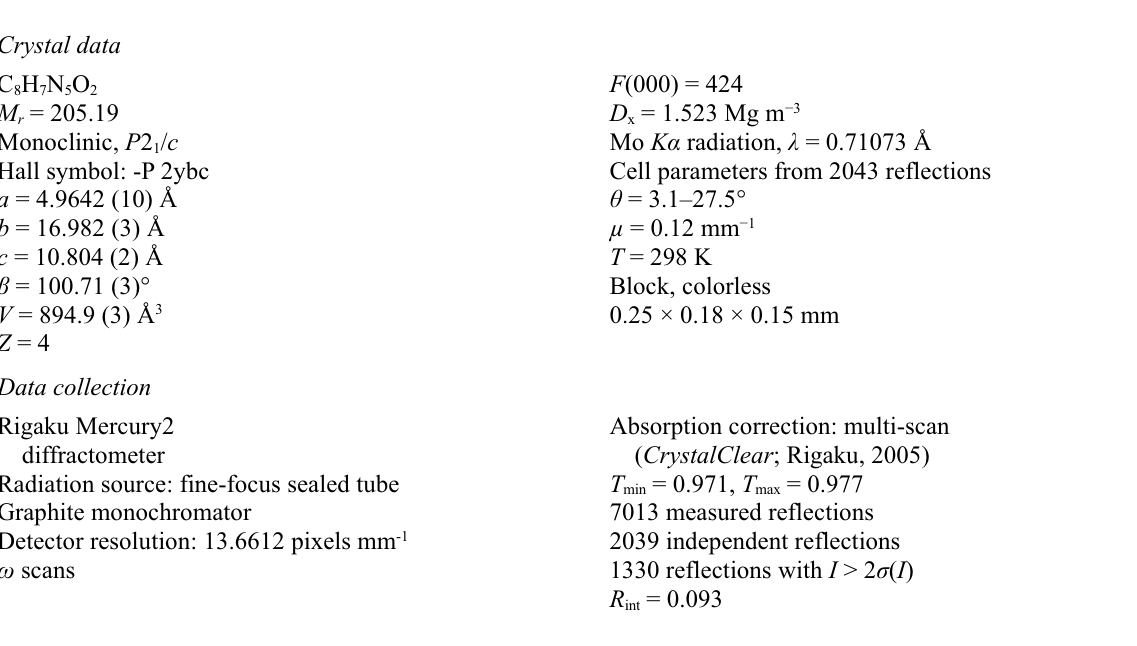
Figure 2 Partial packing of the title compound showing the one dimensionnal hydrogen bondings network. Hydrogen atoms not involved in hydrogen bonding (dashed lines) have been omitted for clarity. [Symmetry code : (i) x-1, y, z] 5-(4-Methyl-3-nitrophenyl)-1 H